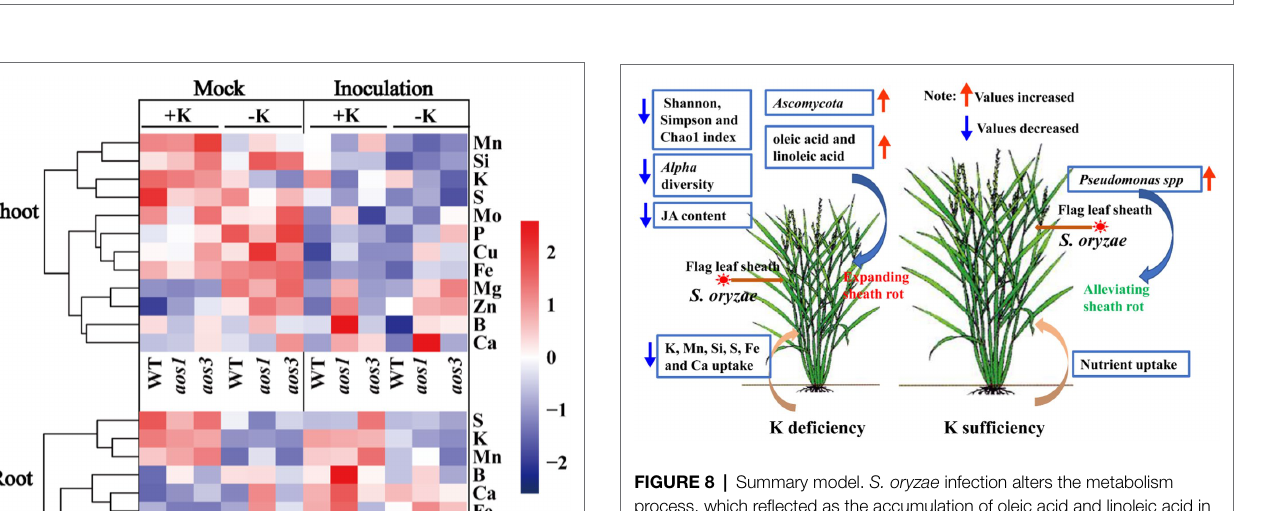
FIGURE 6 | aos mutants show more sensitive to potassium deficiency. * Denotes a significantly differences between − K and + K treatments ( p < 0.05).